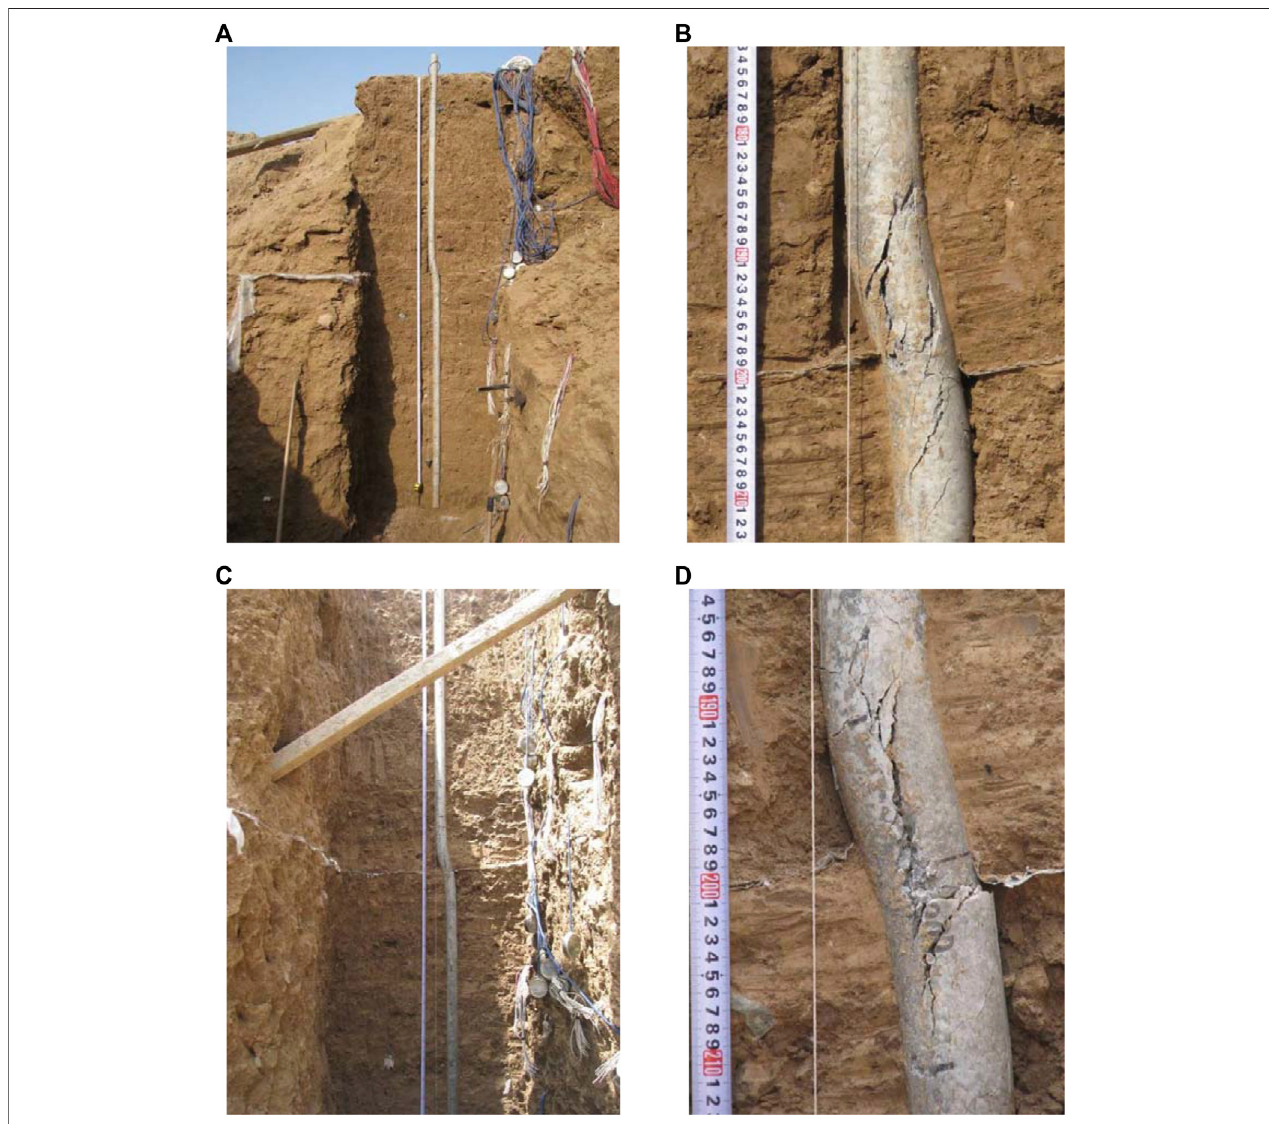
FIGURE 5 | The damage of piles in single-row con fi guration: (A) overall damage of pile D6, (B) breakage of pile D6 near the slipping surface, (C) overall damage of pile D5, and (D) breakage of pile D5 near the slipping surface.